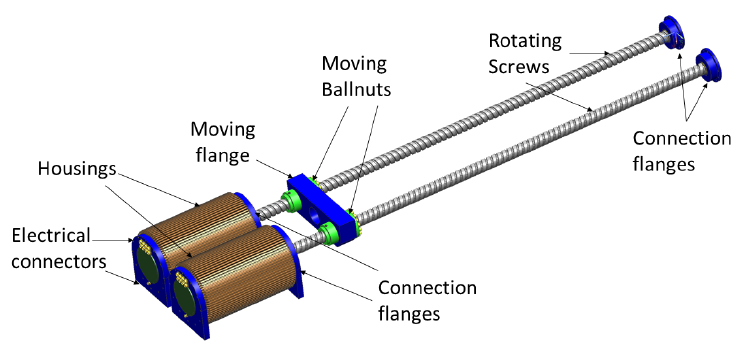
Figure 2. EMG design (IMAGINE project, 2019).